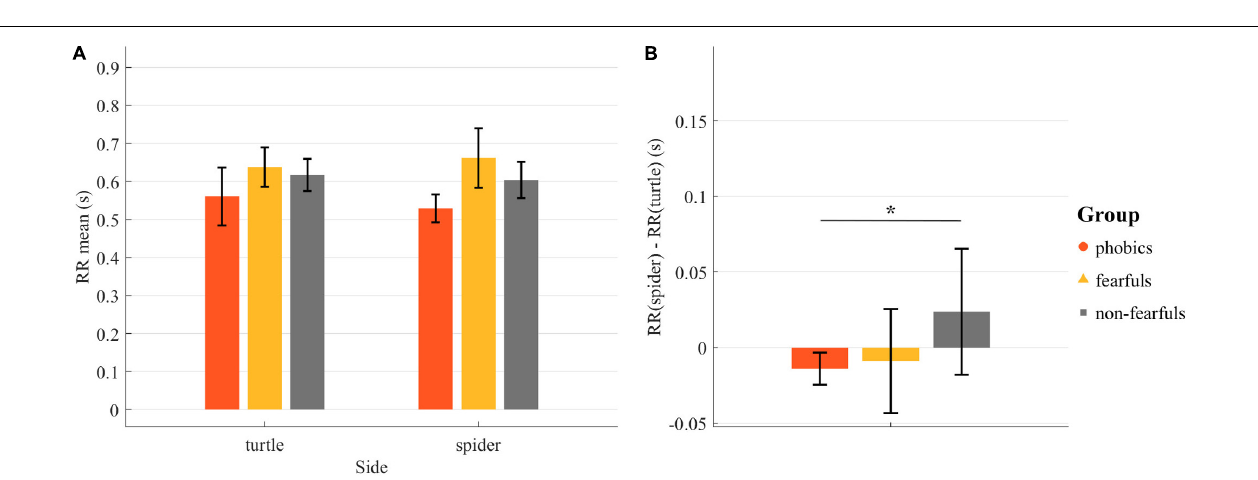
FIGURE 5 | Heart rate analyses during the Fishing task: (A) The mean RR interval in seconds per stimulus side while they stayed there. (B) The individual differences between the mean RR interval on the spider side and the mean RR interval on the turtle side. Bars = group mean; lines = standard error; RR interval = heartbeat to heartbeat duration; * p < 0.05.